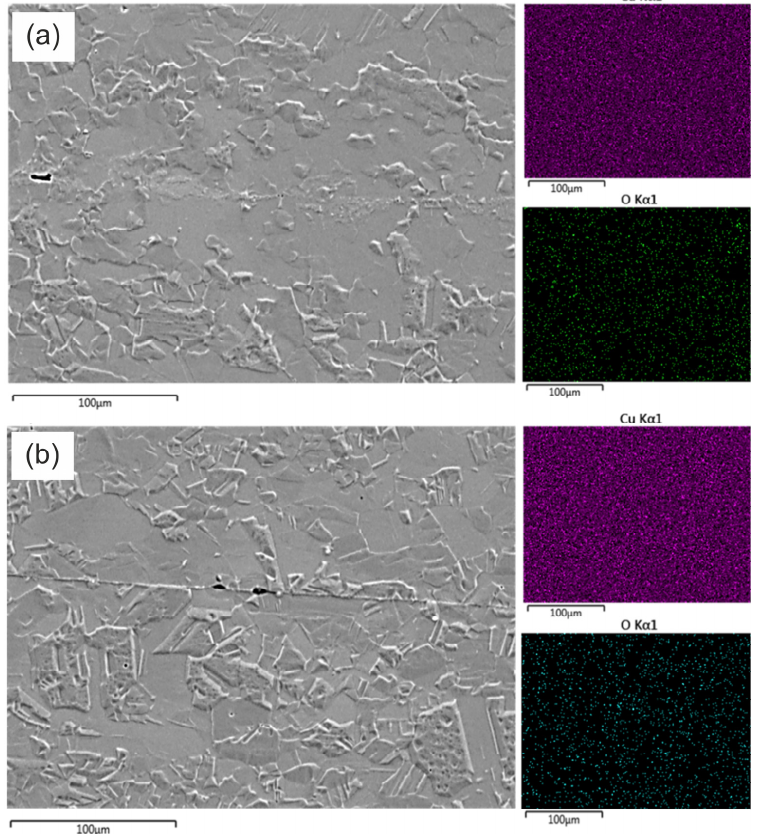
Figure 10. EDX mapping of Cu and O at the weld interface in two different locations along the bonding line, from: ( a ) Figure 9a; and ( b ) Figure 8b.